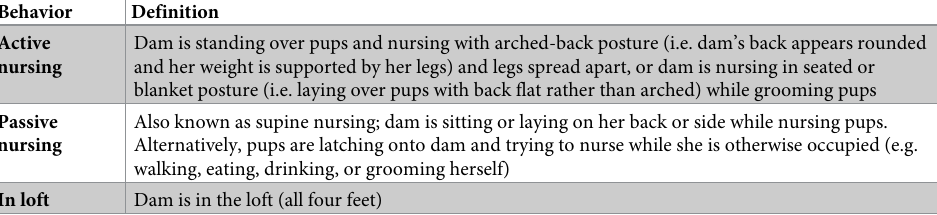
Table 1. Descriptions of dam behaviors scored in home cage